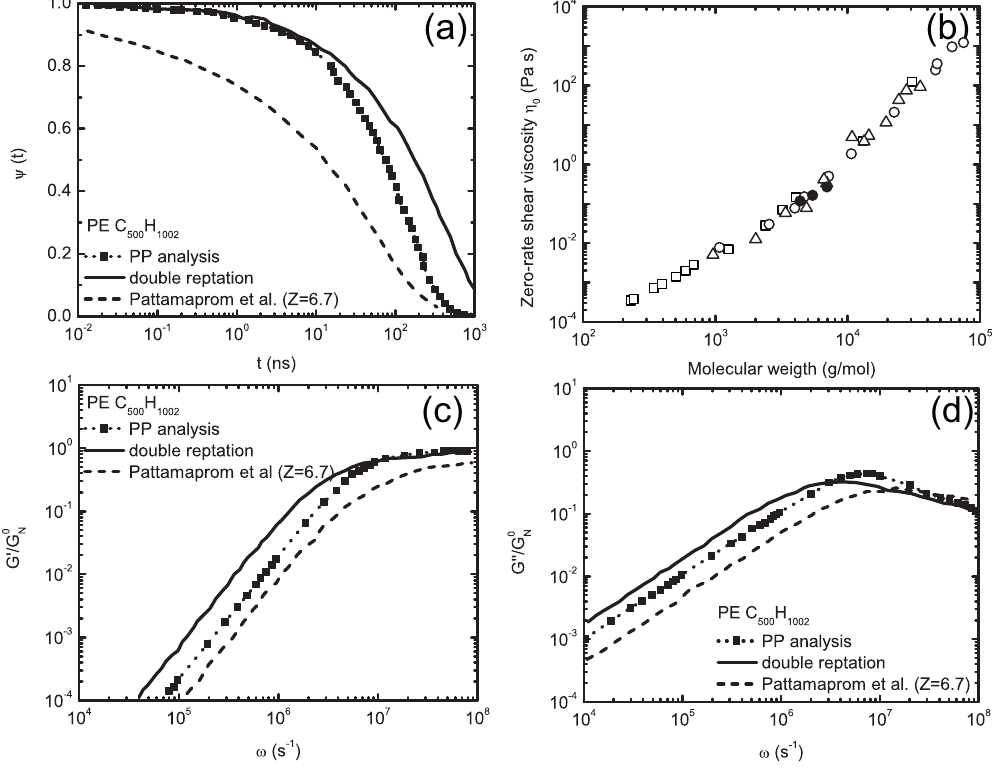
Figure 19. Results of ( a ) tube survivability function, Ψ ( t ) ; ( b ) zero-rate shear viscosity, η ; ( c ) storage, G (cid:48) ( ω ) , modulus; and ( d ) loss, G (cid:48)(cid:48) ( ω ) , modulus of PE (C 0